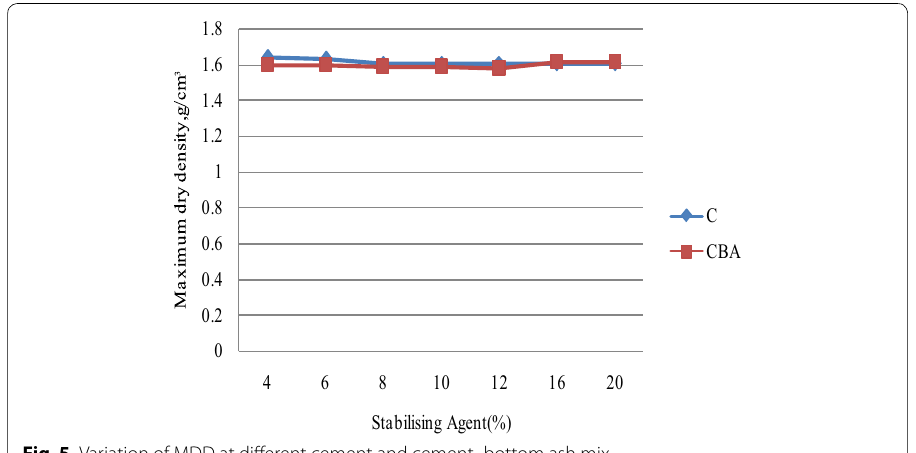
Fig. 5 Variation of MDD at different cement and cement–bottom ash mix